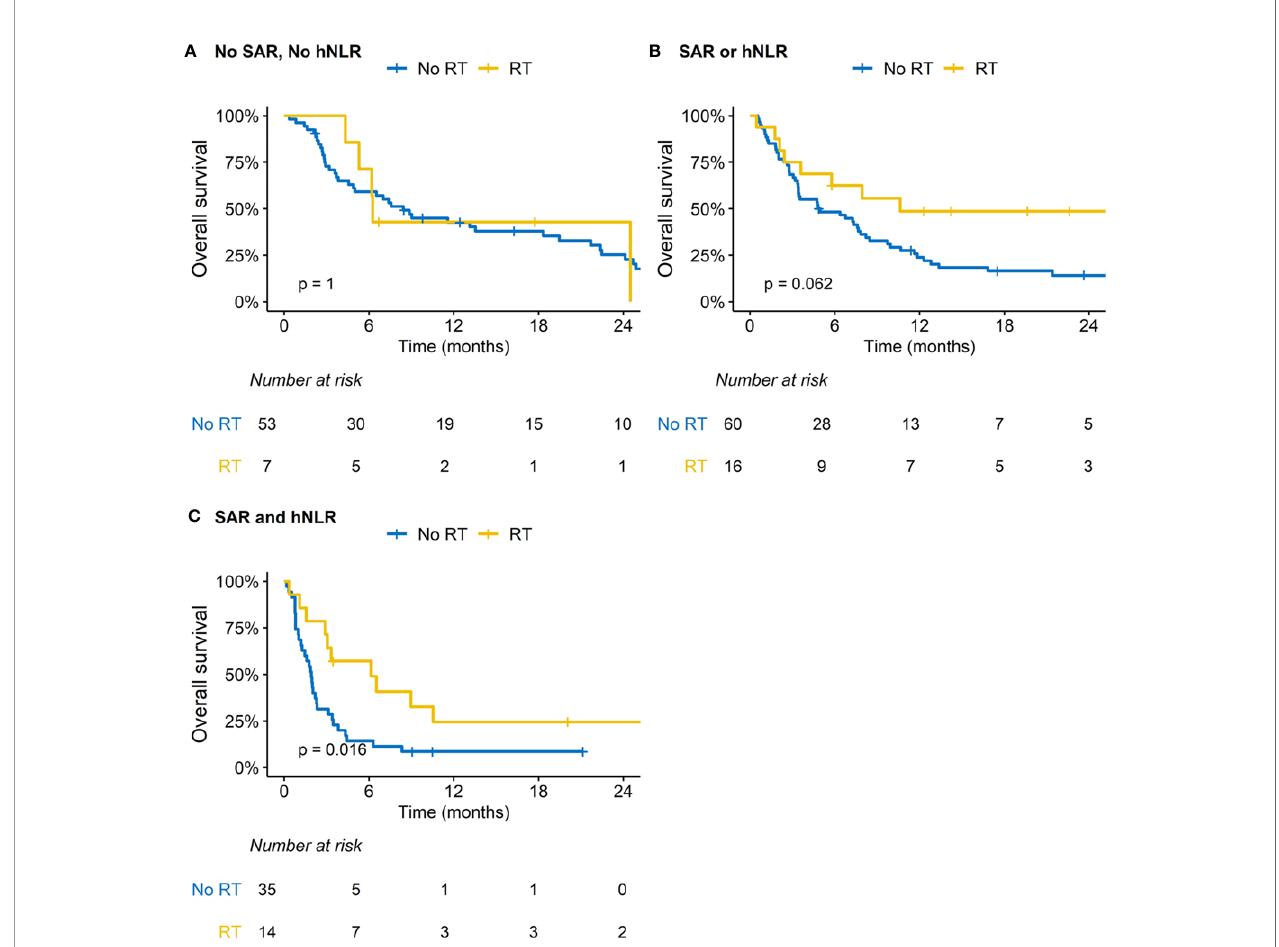
FIGURE 2 | Impact of radiation therapy (RT) on overall survival according to subgroups based on sarcopenia (SAR) and high neutrophil-to-lymphocyte ratio (hNLR). (A) Patients with no SAR and hNLR; (B) Patients with SAR or hNLR; (C) Patients with SAR and